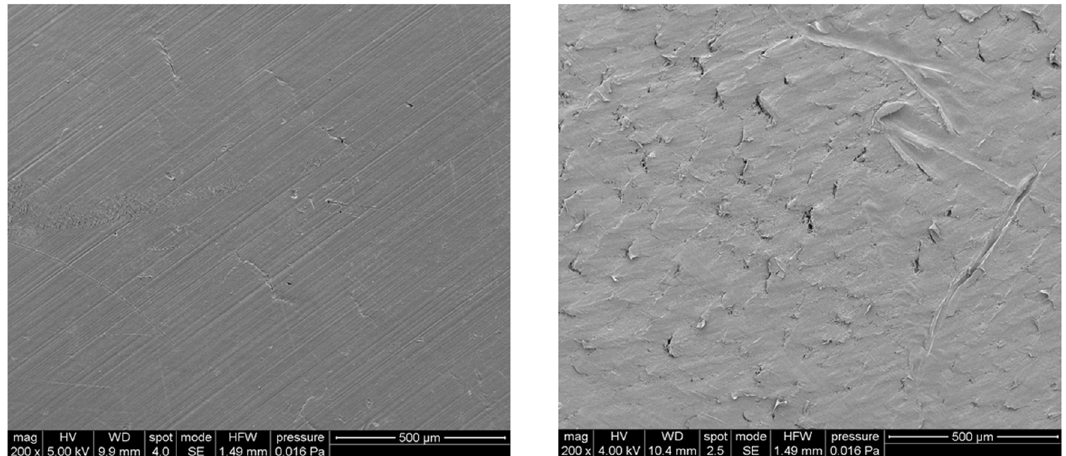
Figure 2. Typical SEM images of poly( ε -caprolactone) (PCL) (left) and PCL/Fe 3 O 4 (right) substrates. Scale bar: 500 μ m.